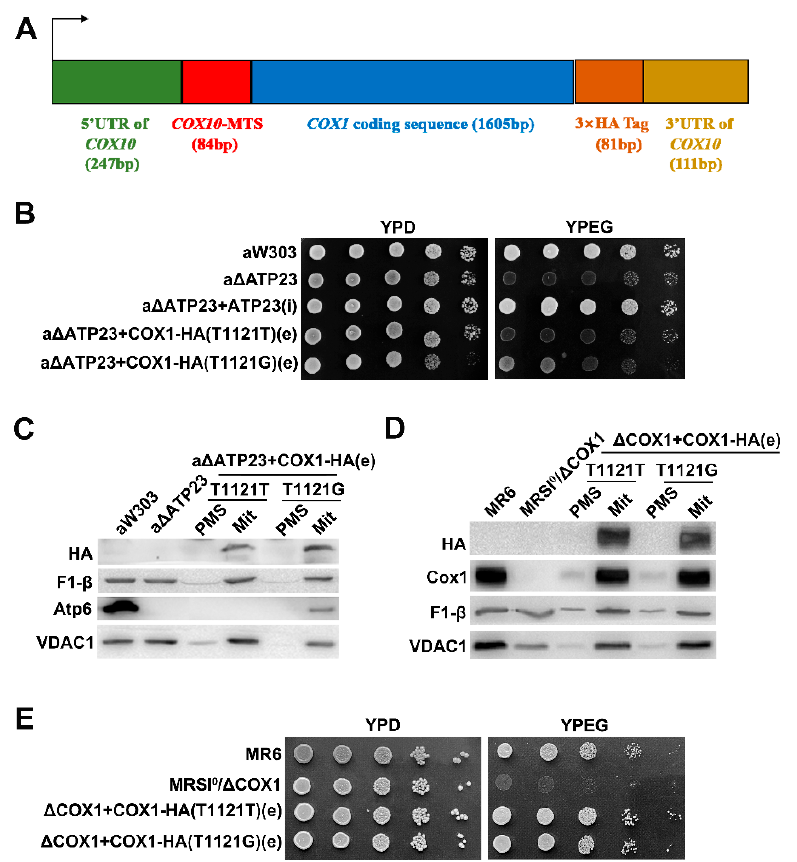
Figure 3. Verification of the suppressor by transformation of exogenous hybrid COX1 construct in atp23 null mutant. ( A ) Diagram of a hybrid COX1-HA plasmid construct. ( B ) Growth of atp23 null mutant transformed with a hybrid COX1-HA construct plasmid on YPD and YPEG medium. aW303 and aATP23 + ATP23(i) were used as positive controls. ( C ) Western-blot analysis of localization of Cox1-HA protein (visualized by antibody against HA), mitochondrial β subunit of F 1 and Atp6 of Fo. Mitochondria (Mit) and the postmitochondrial supernatant fraction (PMS) consisting mainly of cytosolic proteins were prepared from same strains shown in ( B ) except strain aATP23 + ATP23(i). Samples of mitochondria and PMS containing 40 µ g protein were analyzed. ( D ) Western-blot analysis of the localization of Cox1-HA protein (visualized by antibody against HA and anti-Cox1), and mitochondrial β subunit of F 1 . Mitochondria (Mit) and post-mitochondrial supernatant fraction (PMS) were prepared from cox1 null mutant transformed with hybrid COX1-HA construct plasmid. Samples of mitochondria and PMS containing 40 μ g protein were analyzed. ( E ) Growth of cox1 null mutant transformed with hybrid COX1-HA construct plasmid on YPD and YPEG medium. MR6 was used as a positive control.